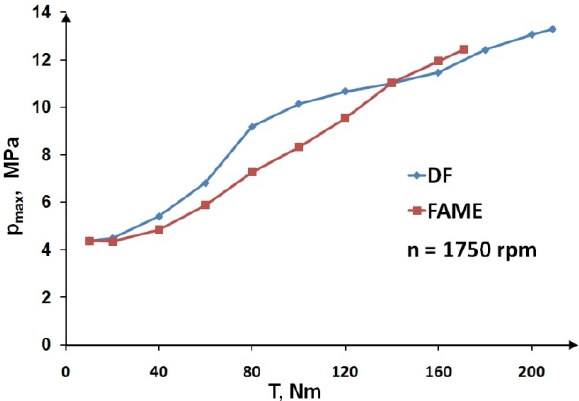
Figure 3: Comparison of the maximum combustion process pressure values p max in the cylinder of the Fiat 1.3 MultiJet engine working according to the load characteristics for n = 1750 rpm and supplied with the following fuels: FAME,